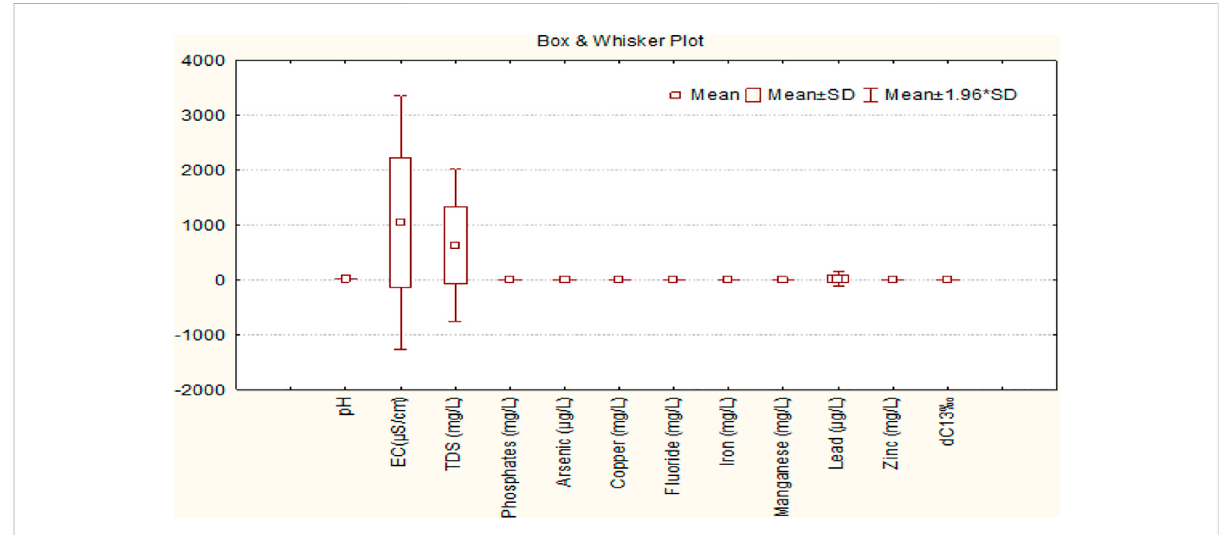
FIGURE 5 Box and whisker plots of physicochemical parameters, heavy metals, and δ C 13 in the groundwater of the “ twin cities ” of Rawalpindi and